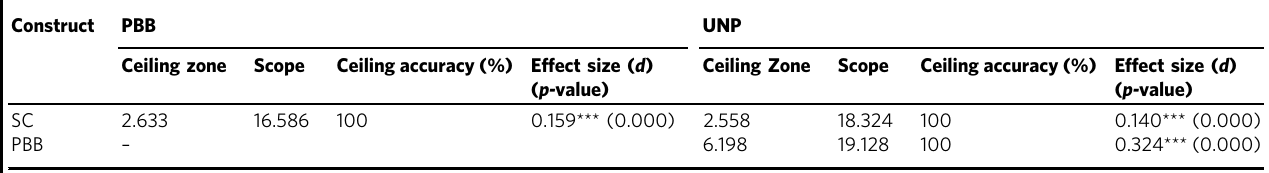
Table 7 Analysis results of NCA (CE-FDH).